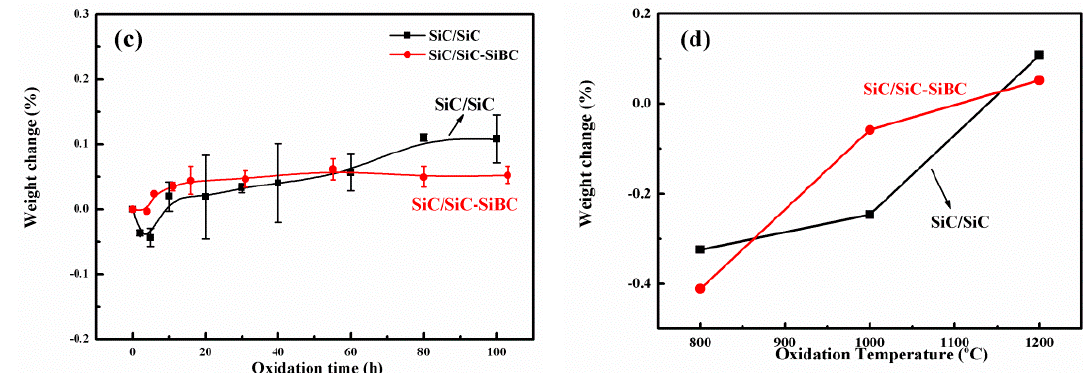
Figure 4. Weight variation of SiC/SiC and SiC/SiC-SiBC oxidized for 100 h at ( a ) 800 °C, ( b ) 1000 °C, ( c ) 1200 °C; ( d ) and the total weight variation for both two composites after oxidation of 100 h at different temperatures.